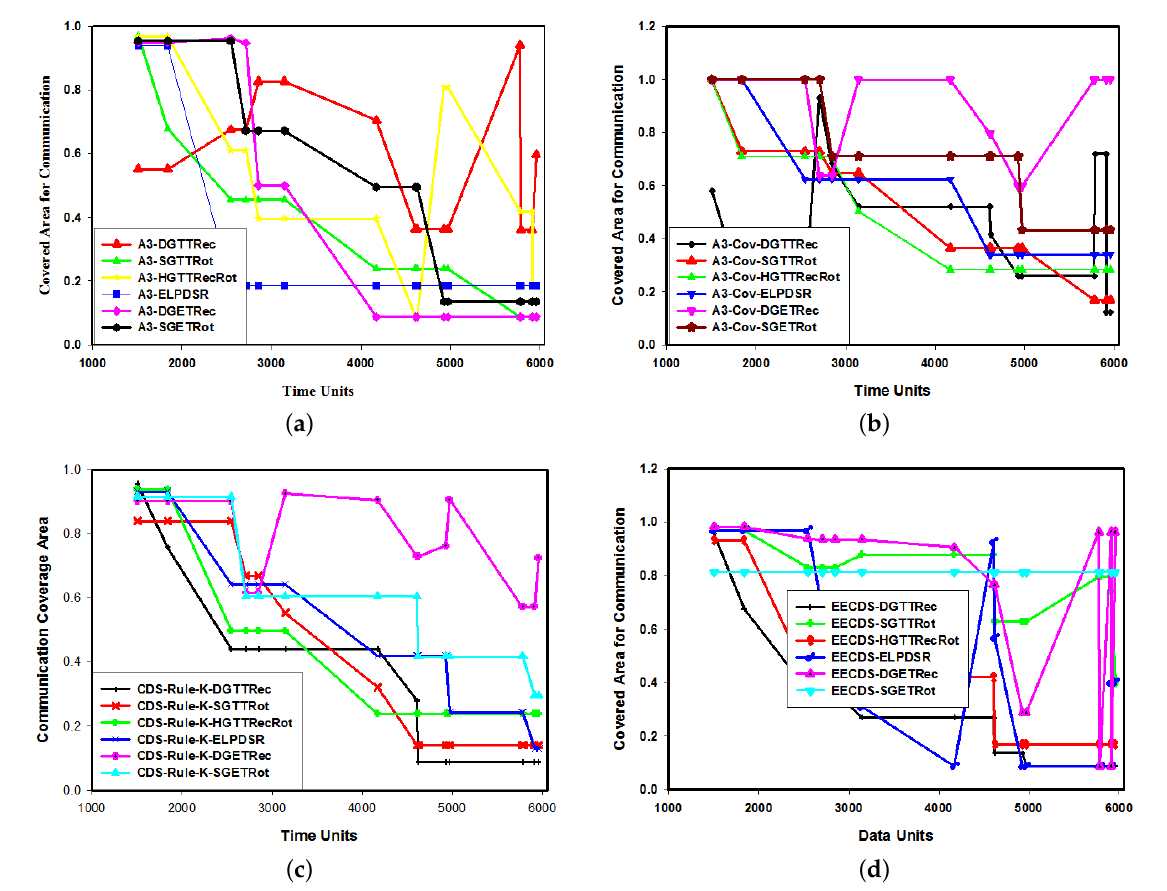
Figure 8. Topology maintenance for communication coverage area using ( a ) A3, ( b ) A3-Cov, ( c ) CDS-Rule-K and ( d ) EECDS